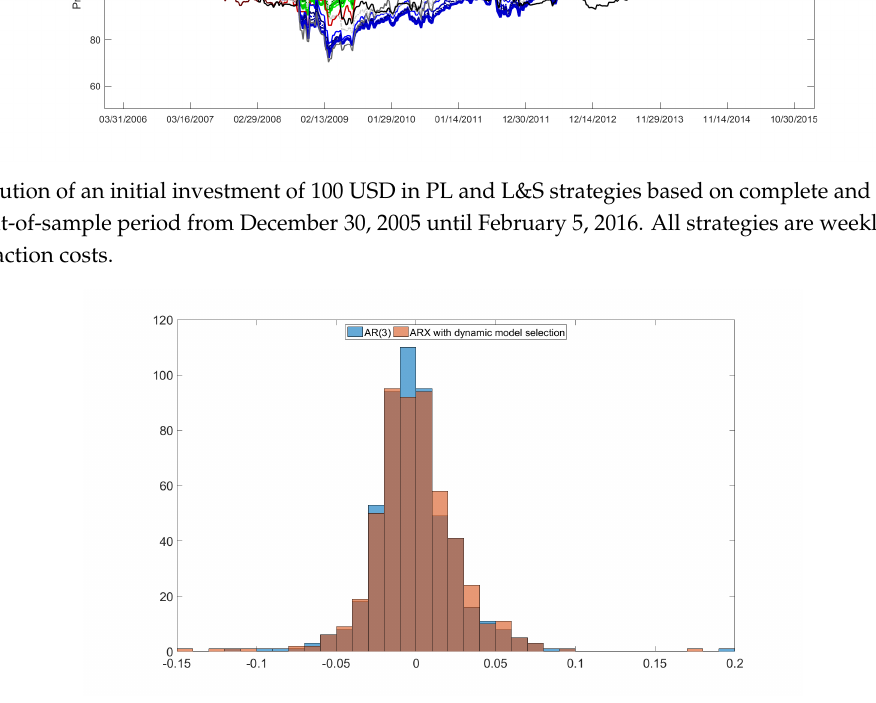
Figure A8. Differences between point forecasts and realizations of weekly S&P500 log-returns. The blue histogram shows such differences, when the return predictions arise from an AR(3). The orange histogram uses forecasts of our ARX based on mixed-frequency panel